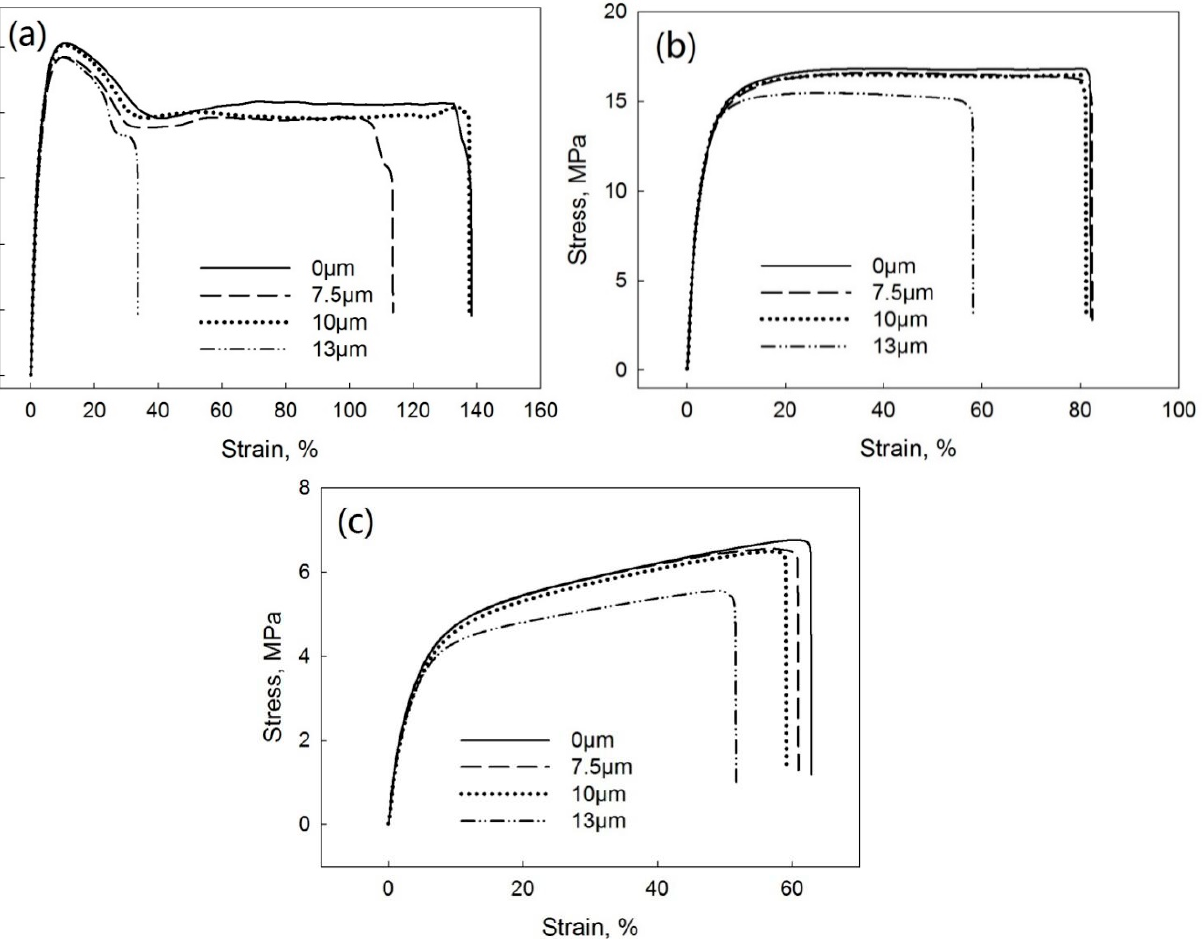
Figure 10. Stress–strain curves of PP/EPDM 75/25 ( a ), 50/50 ( b ), and 25/75 ( c ) blends prepared at different ultrasonic amplitudes by the OS method.